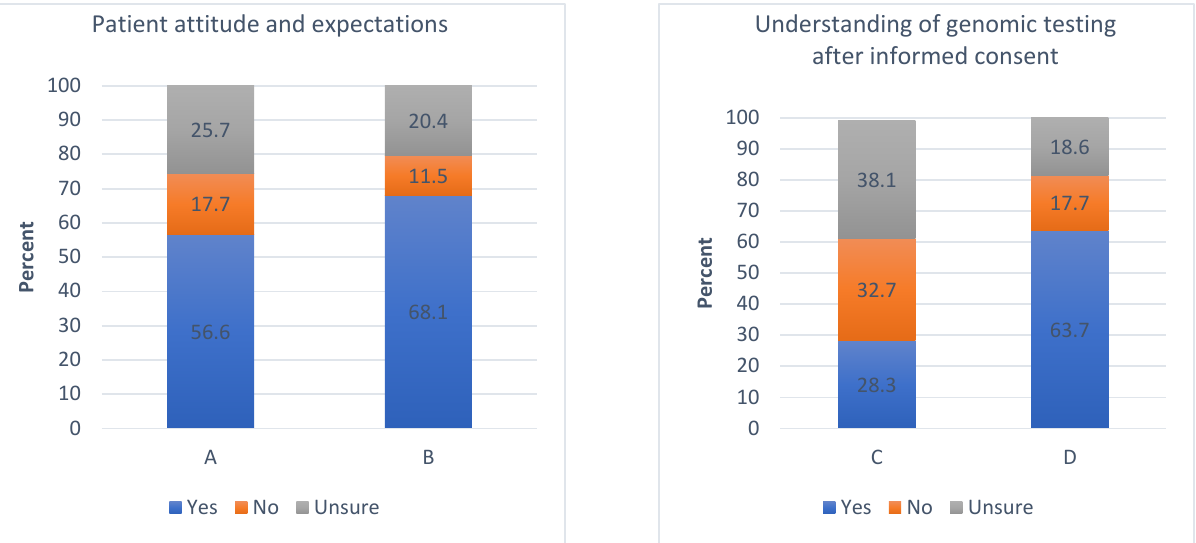
Figure 2. Patient responses to questions (in percentages) for attitude and expectations towards genomic testing and research. ( A ). I would only want to receive genomics test results that would influence my current or future cancer treatment decisions. ( B ). For example, I would want to receive genomics test results about my family’s inherited risk of developing cancer. ( C ). Do you think you